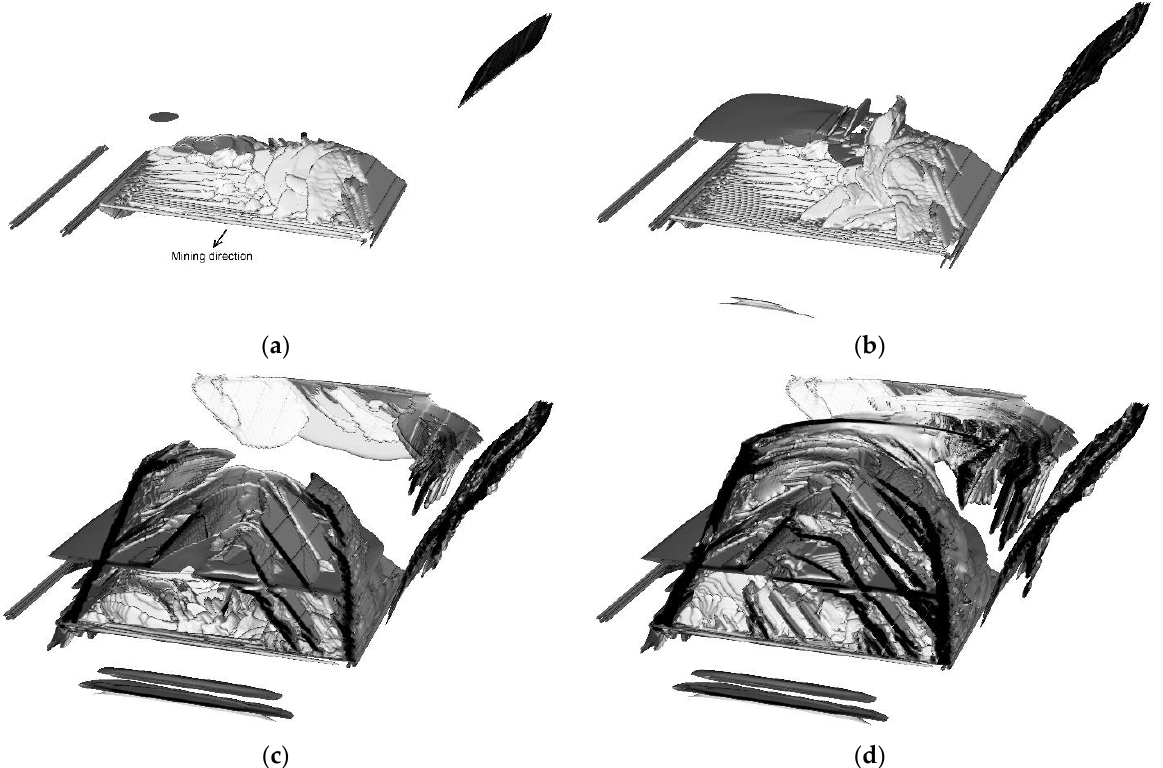
Figure 5. Stages of inelastic deformation development in the course of the gob increase from panel 1: ( a ) 136 m, ( b ) 178 m, ( c ) 203 m, and ( d ) surface subsidence state.